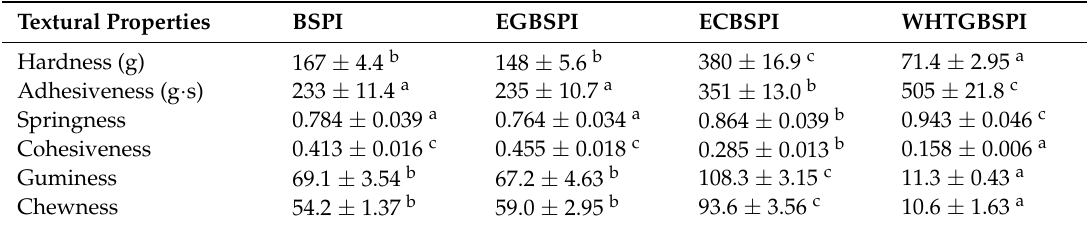
Table 3. Textural properties of acid-induced gels prepared by BSPI and its modified products.